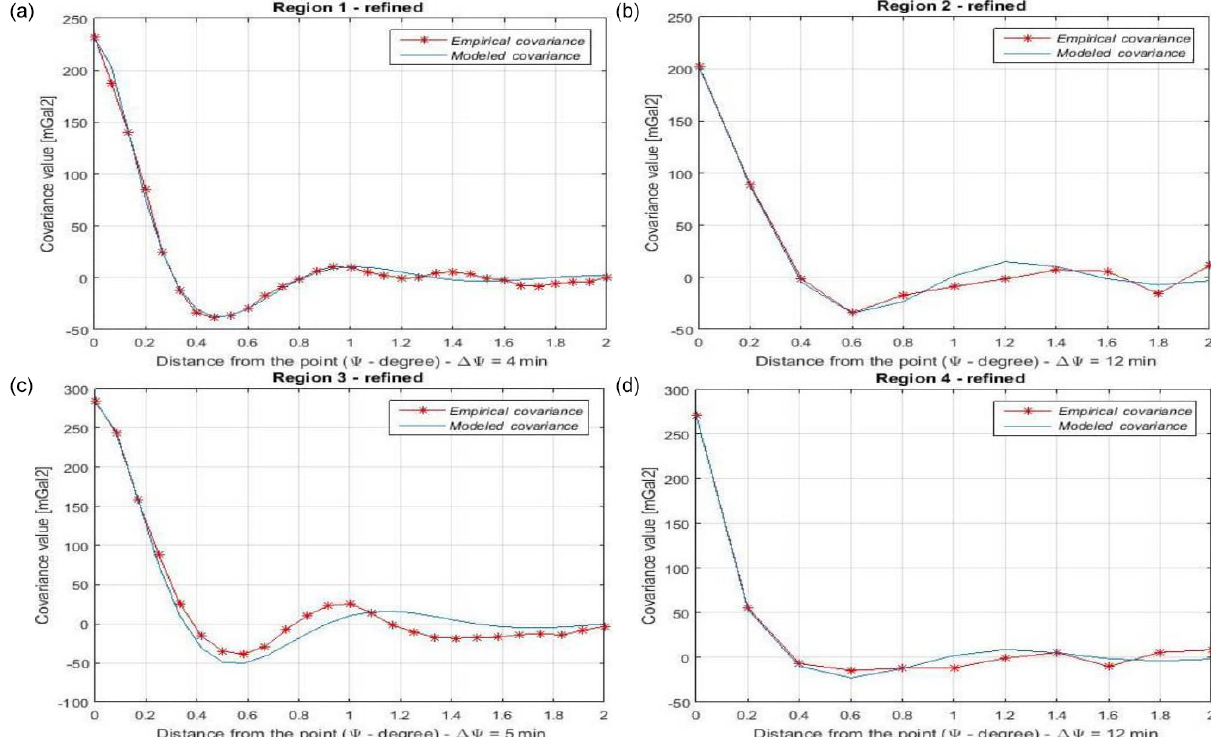
Figure 5. Empirical and fitted COV for the regions (a) R1, (b) R2, (c) R3 and (d) R4 after refining the data distribution.